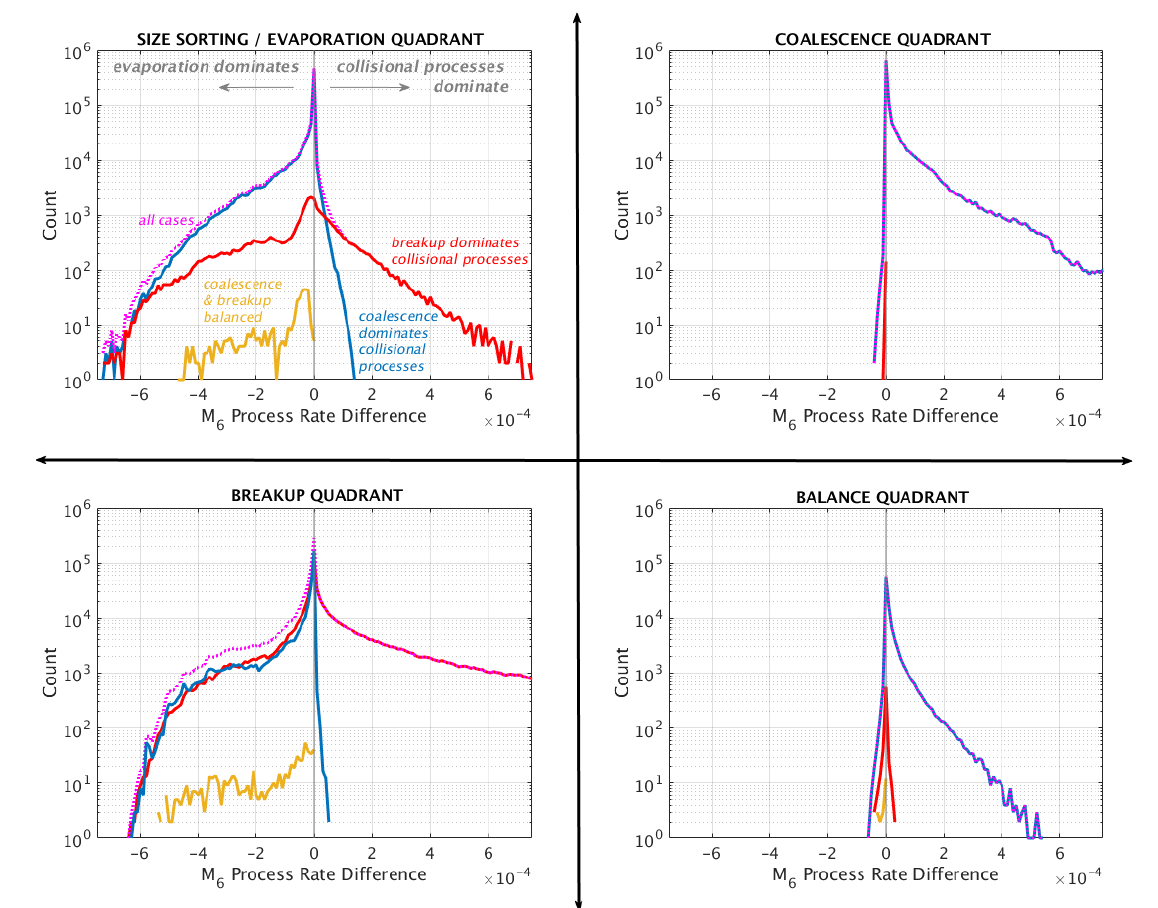
Figure 10. The [44] parameter space showing the observational fingerprint quadrants. In each, histograms show the difference in the actual process rates: collisional processes—evaporation. If evaporation dominates changes to M6, the resulting difference is negative ( left of vertical gray line). If collisional processes dominate over evaporation, the result is positive ( right of vertical gray line). Magenta dotted shows distributions of all cases that fit into those quadrants. These are subdivided into those for which coalescence dominates the collisional process rates (blue), breakup dominates the collisional process rates (red), or they are balanced (goldenrod); these are annotated in the top left quadrant. Number of data points included in each quadrant as follows: coalescence n = 1,087,210; evaporation/size sorting n = 765,021; breakup n = 1,016,795; balance n =